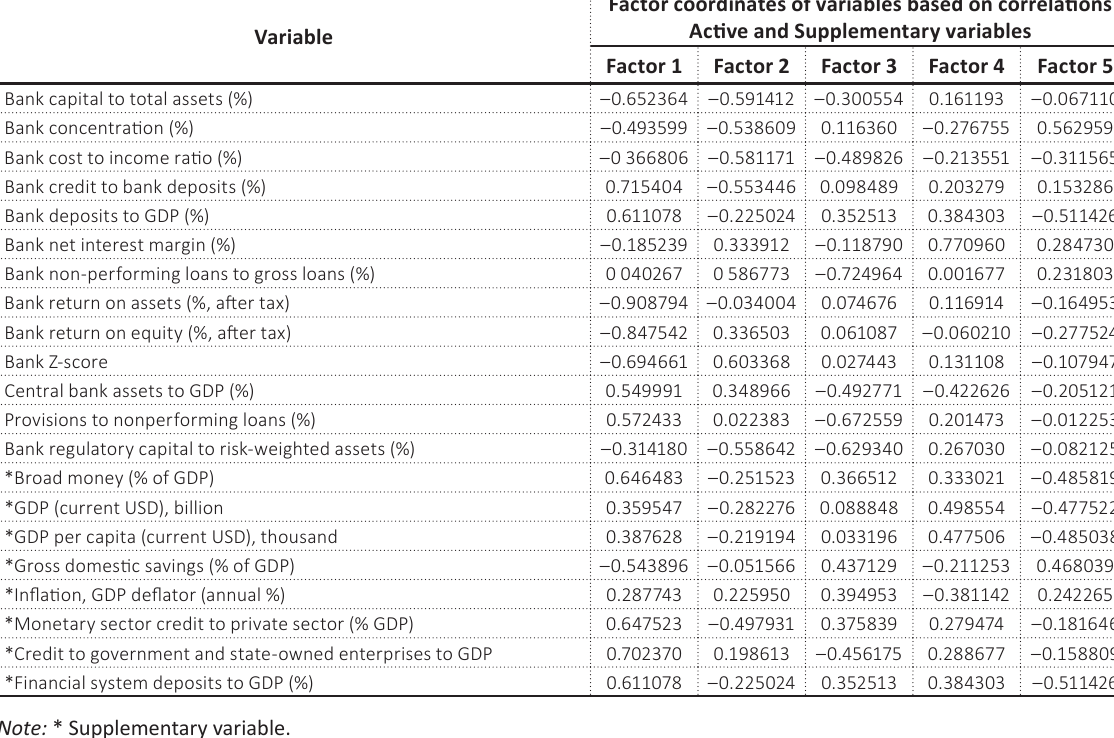
Table 2. Table of coordinates of output factors